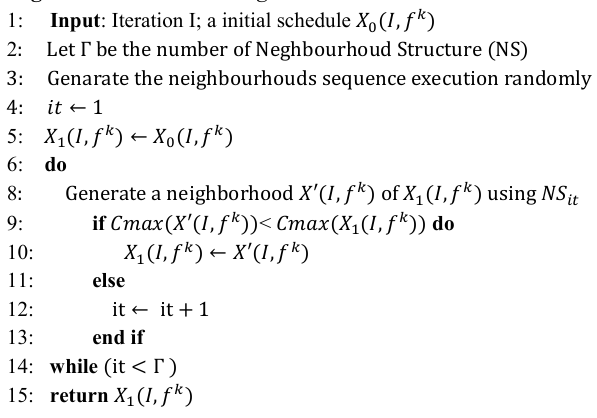
Algorithm2: Variable Neighborhood